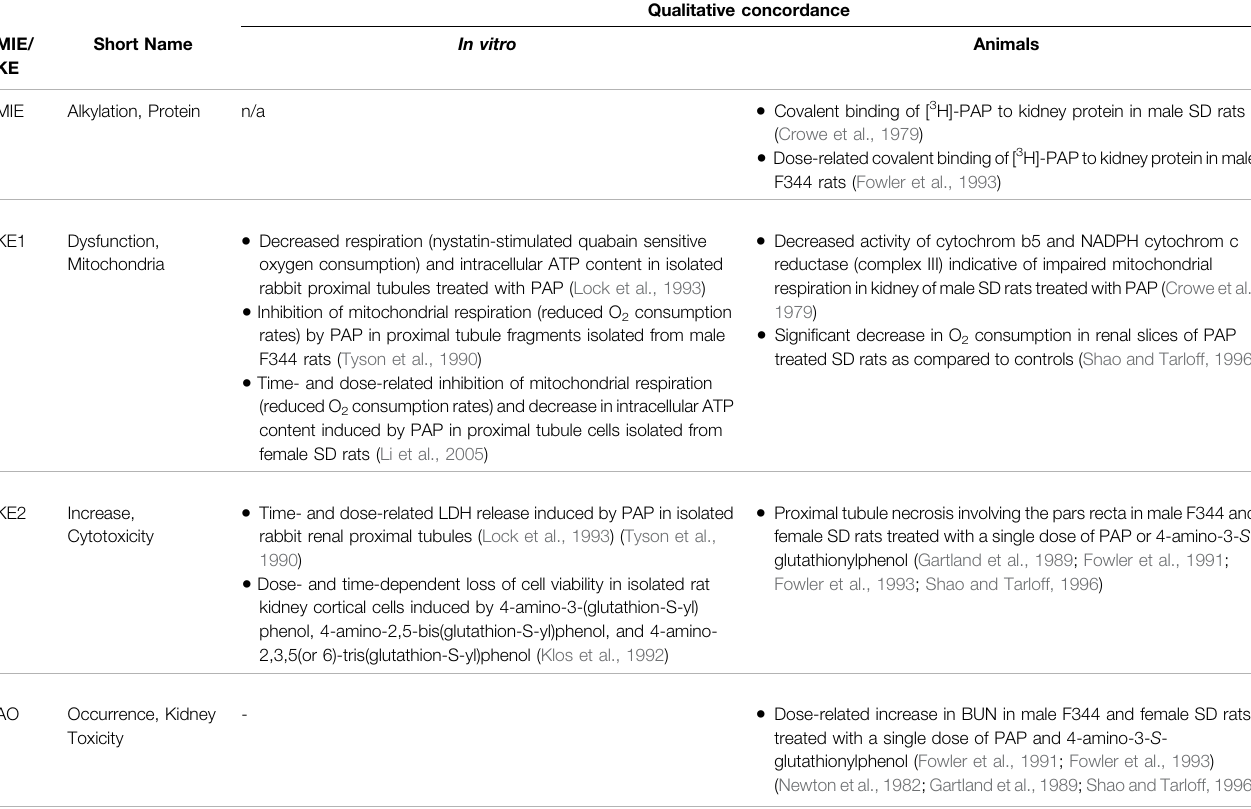
TABLE7E| Evidencefromanimaland invitro studieson 4-aminophenol(PAP) anditsnephrotoxicGSHconjugatessupportingthekeyeventsandqualitativeconcordance of KEs within this AOP. Human toxicity data on PAP are not available (EPA, 2005). (n/a = no data available). Qualitative